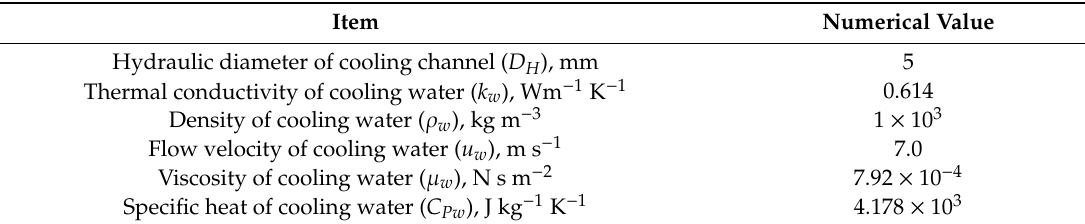
Table 2. Physical property data of primary cooling water.